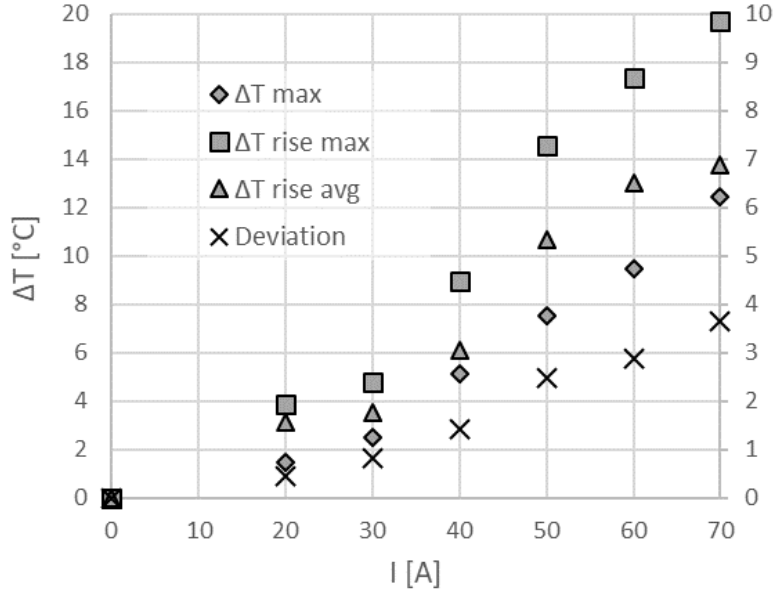
Figure 12. Relatives temperatures and deviation in forced